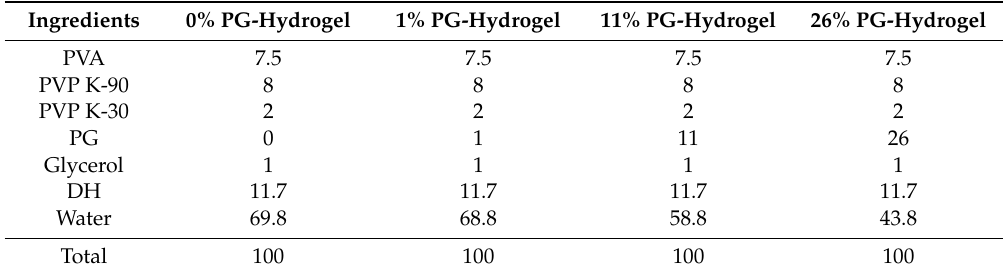
Table 2. Composition of prepared hydrogels (%, w /